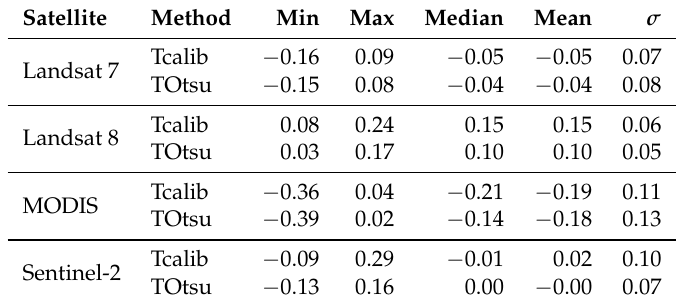
Table 3. Threshold variations based on individual calibration on ground truth data (Tcalib) and calibration with the Otsu